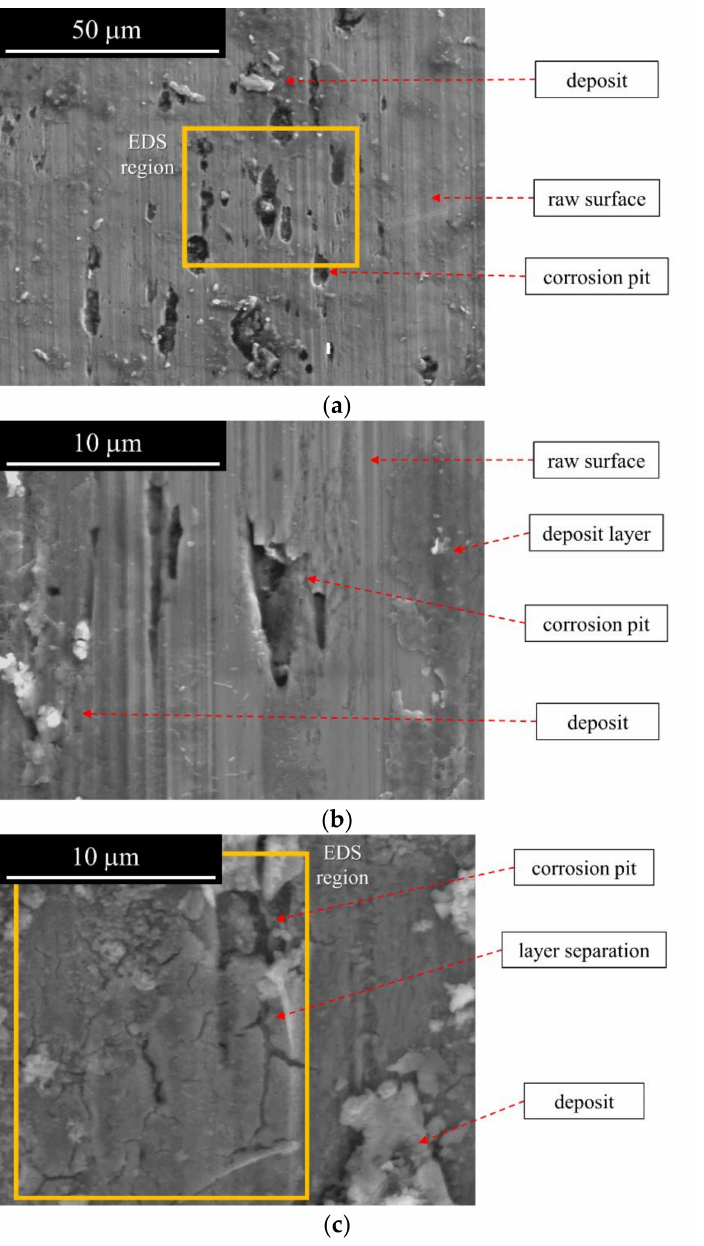
Figure 11. SEM images of notch surface regions after the test and the EDS detecting region (orange box) ( a ) blunt notch ( r = 2.0 mm), ( b ) medium notch ( r = 0.5 mm), and ( c ) sharp notch ( r = 0.1